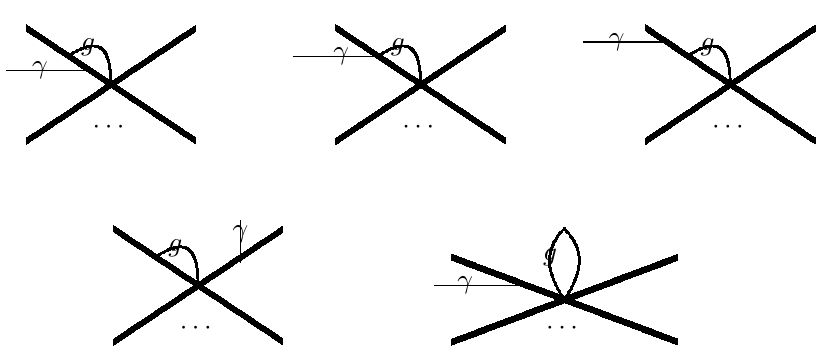
Figure 25 . Diagrams with external soft photon and an internal graviton where the internal graviton attaches to the n -point